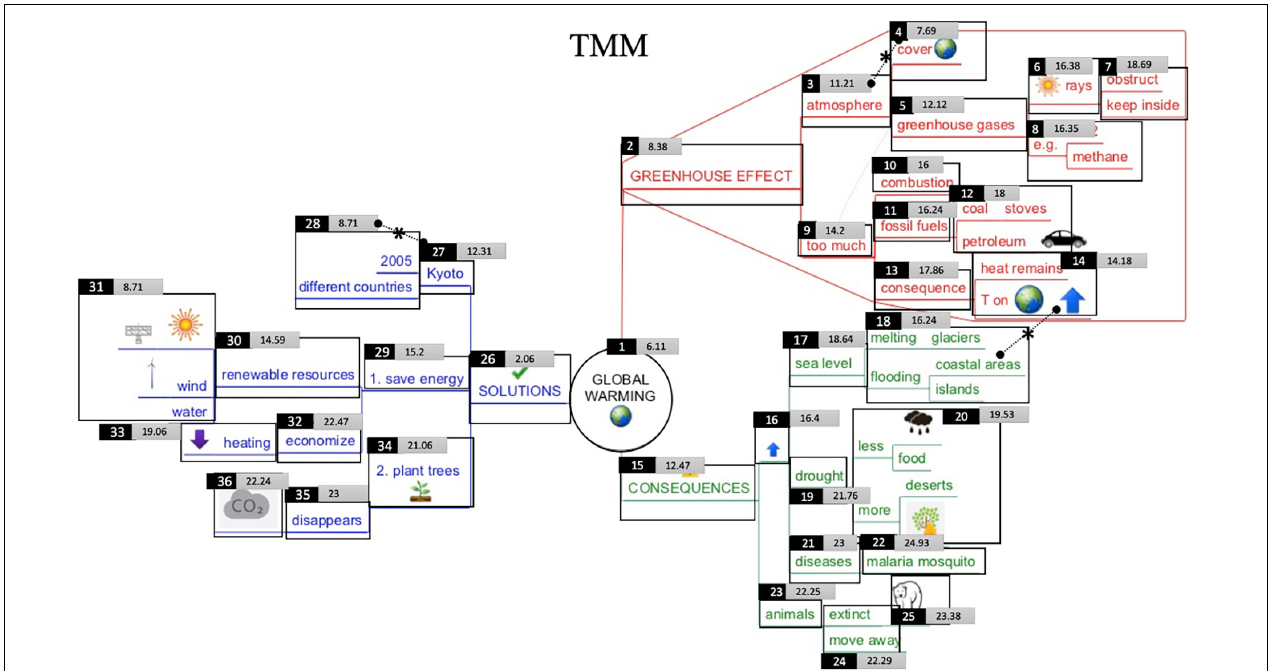
FIGURE 5 | Visualization of students’ early attention in the Text-Mind Map condition (TMM). The smaller the number in the light gray rectangle, the earlier attention that particular Interest Area received in the first-pass reading process. Interest area number is located at the upper left of the IA. Level-1 branches = IA 2–15–26;